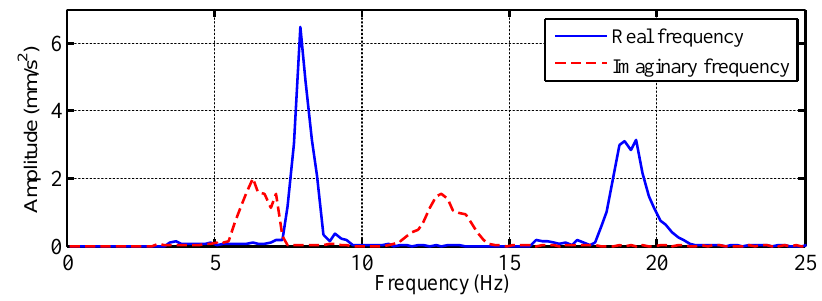
Figure 6. Marginal spectrum of simulated chatter signal.